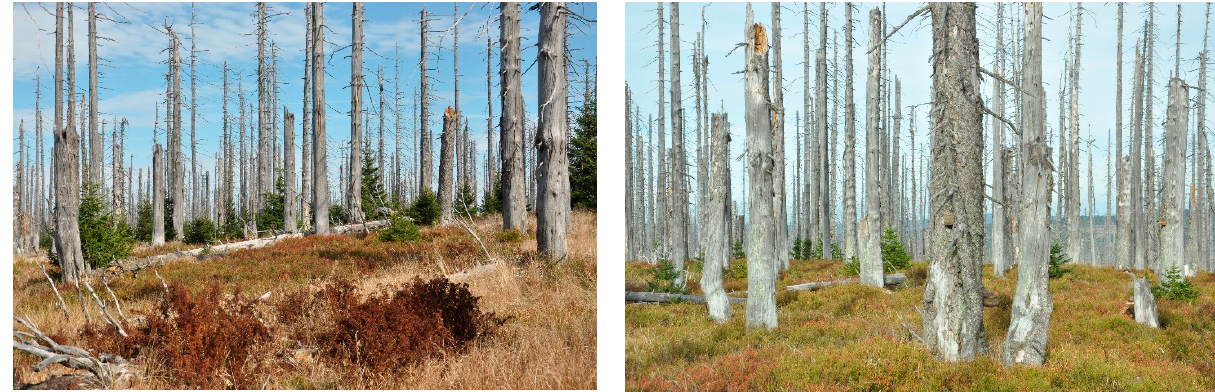
Figure 1. Dead trees in Šumava National Park, Czech Republic (Ing. Tomáš Koutecký, Ph.D).